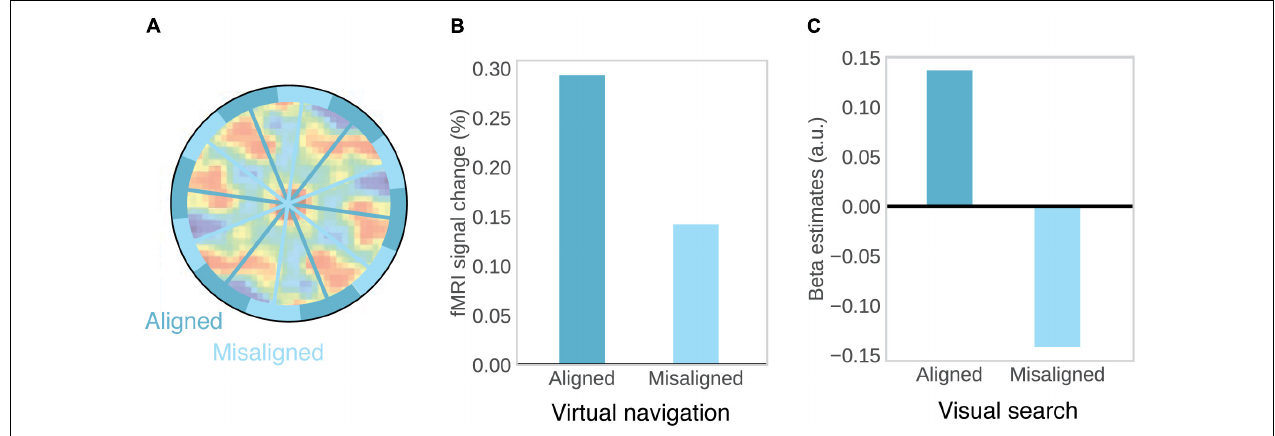
FIGURE 2 | Evidence for grid-cells in fMRI BOLD. (A) Rationale for observing grid-like activity in BOLD contrast. Based on the assumption that grid cells show a similar grid orientation across the population, movement in a direction aligned with the common grid direction should be associated with higher firing rates across the population and therefore higher BOLD signal than movement in a direction misaligned with the grid. Underlying autocorrelation function adapted with permission (Jacobs et al., 2013) from Springer Nature. (B) During virtual navigation, movement in a direction aligned with grid orientation, which was estimated from an independent subset of the data, resulted in higher BOLD in the entorhinal cortex than movement in a direction misaligned with the grid. Data from Doeller et al. (2010). (C) Analogously, eye movements in a direction aligned with grid orientation in a visual tracking task are associated with higher BOLD than eye movements in a direction misaligned with the grid. Data from Nau et al.